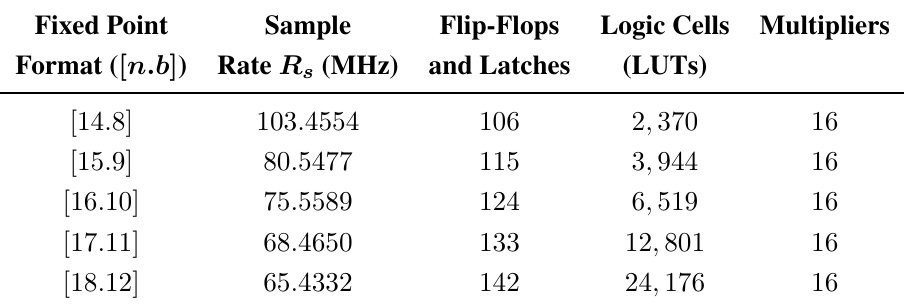
Table 5. Processing speed and area occupied for different fixed point formats, in the sine function